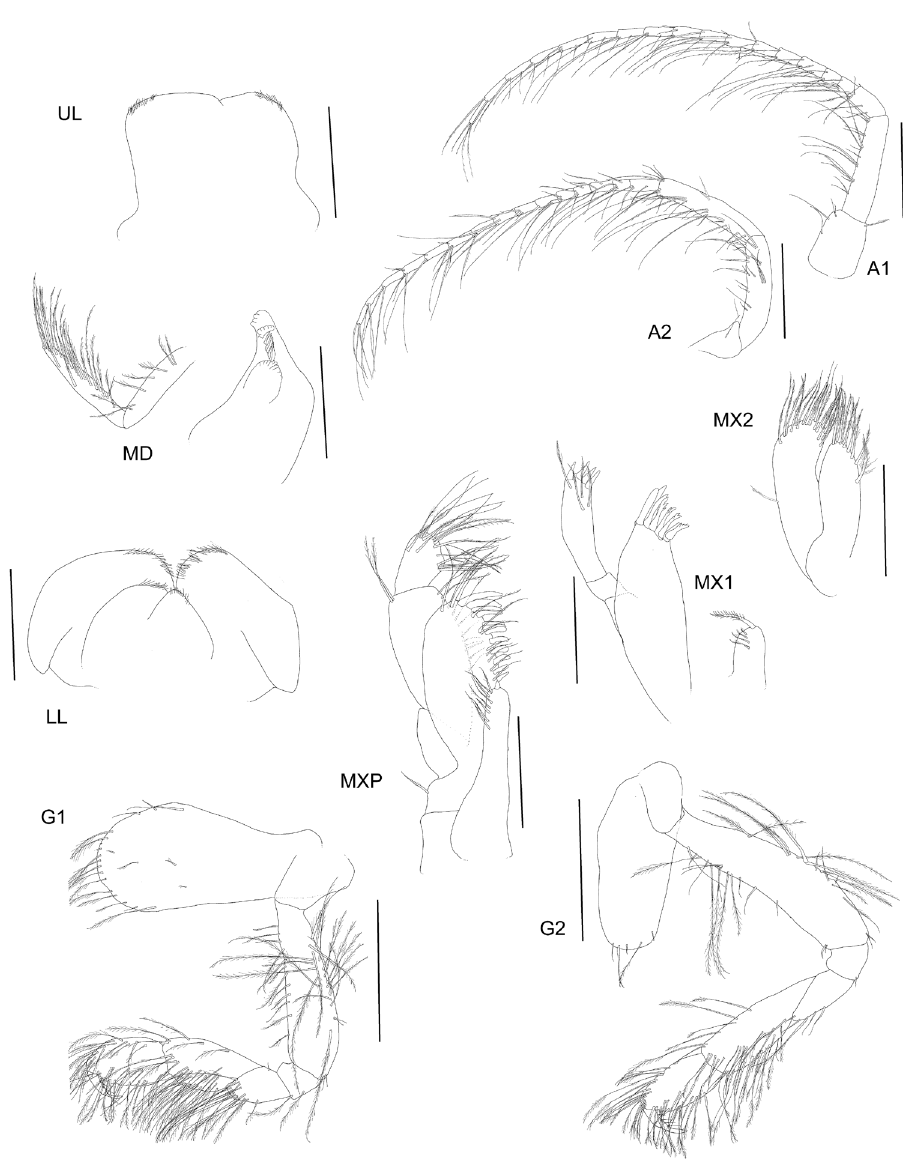
Figure 6. Haploops dauvini sp. n., holotype, female, 7 mm, ZMH K-47038, Norwegian Channel, 587.4–614.4 m. Antennae 1–2, gnathopods 1–2 scales represent 0.5 mm. Mouthparts scales represent 0.2